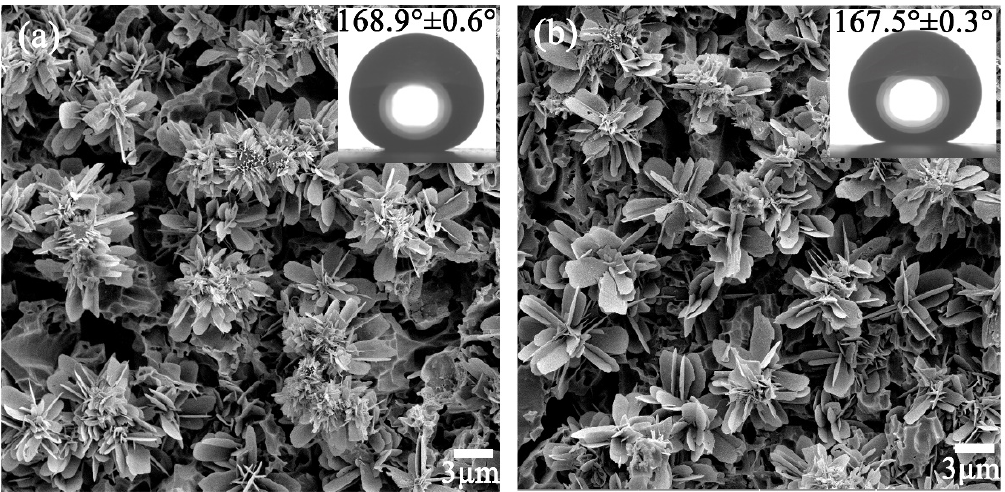
Figure 12. SEM images after peeling for ( a ) 10 and ( b ) 20 times with 3M scotch tape. Inset: WCA values.